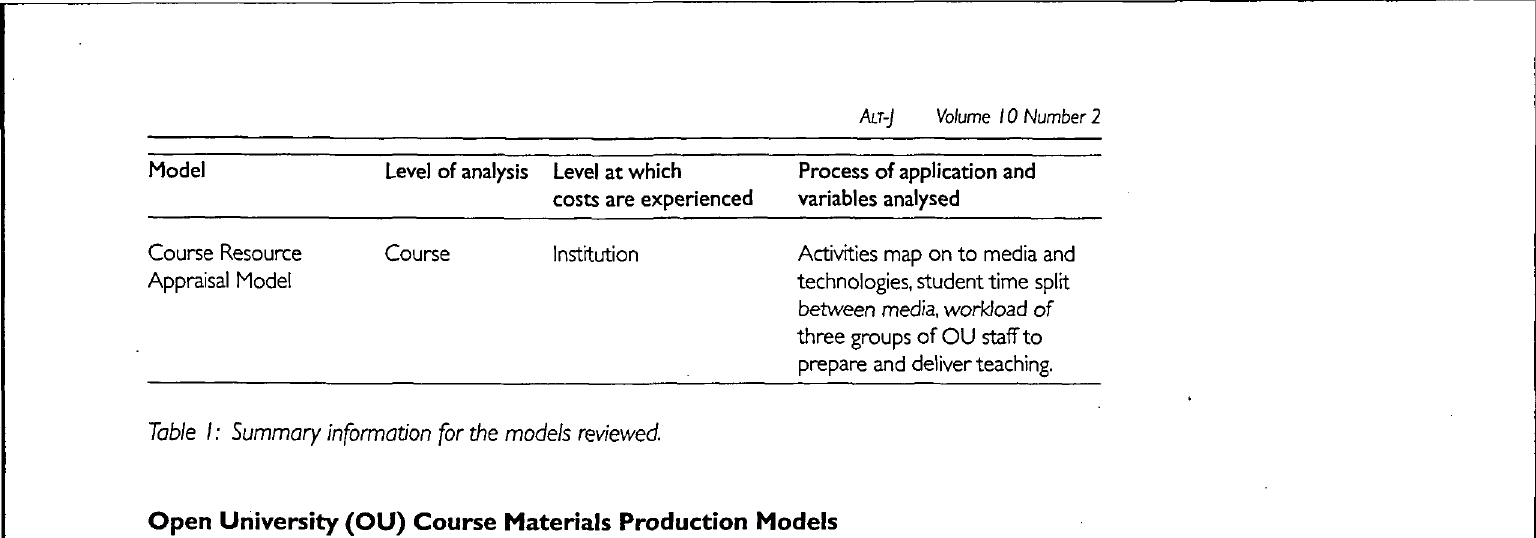
Table I: Summary information for the models